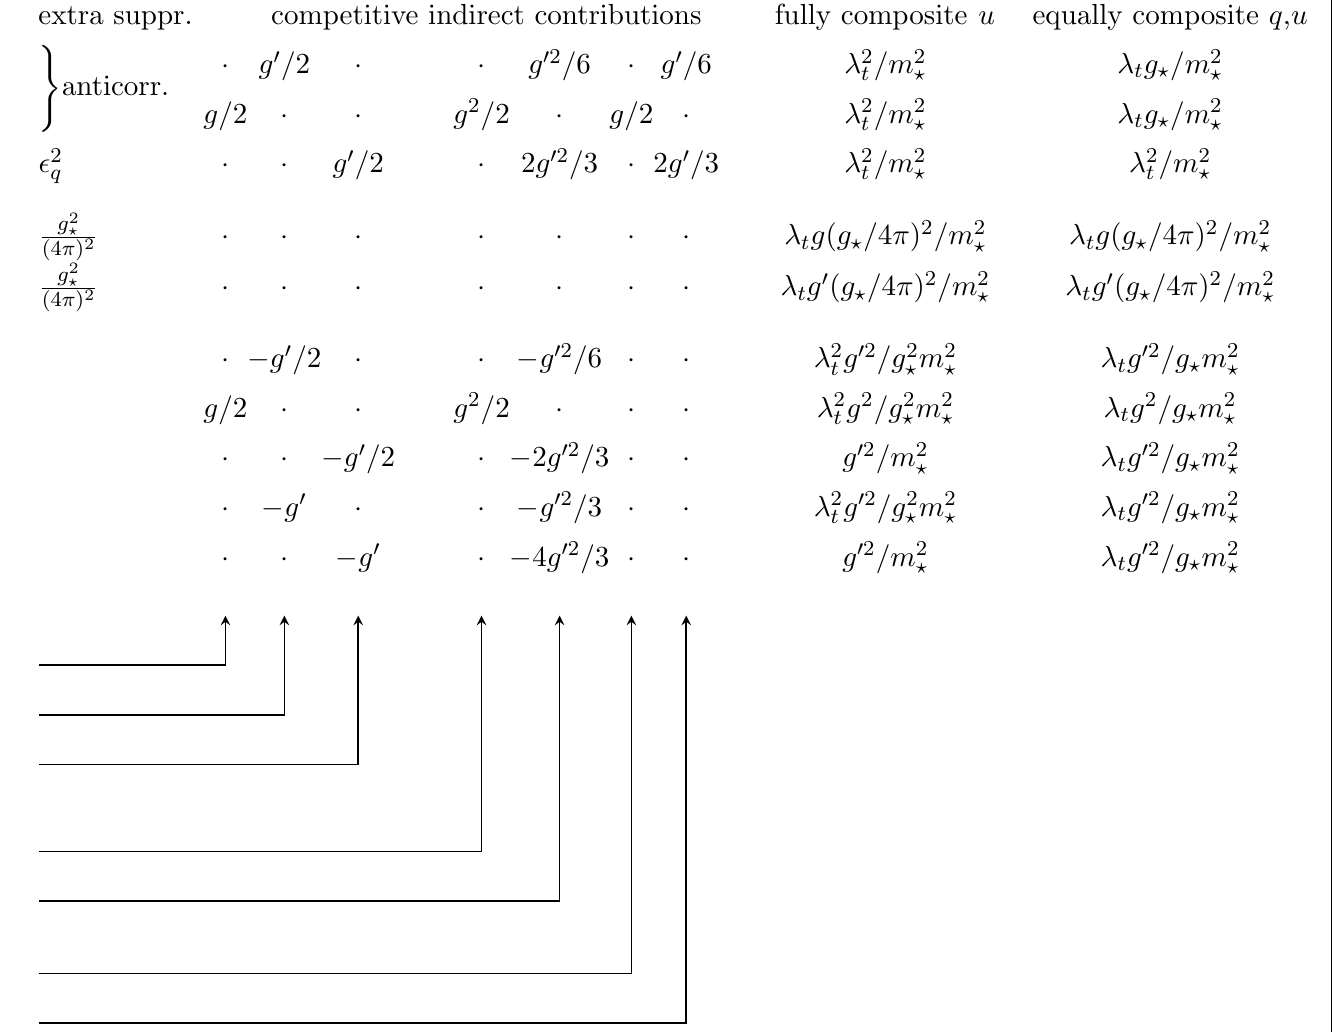
Table 1 . First column: direct application of the power-counting rules to estimate the coe(cid:14)cients of Warsaw-basis operators contributing to third-generation quark production and enhanced by top-quark mixings. Redundant operators from which they receive contributions, after application of the eom s for the electroweak gauge (cid:12)elds, are listed too. Second column: extra suppression arising from selection rules. Third column: additional factors a(cid:11)ecting the indirect contributions of redundant operators to Warsaw-basis operators after application of the eom s. Fourth and (cid:12)fth columns: dominant contributions in the case of a fully composite t ( (cid:15) t = 1, (cid:15) q = (cid:21) t =g ? ) p and of equally composite q and t ( (cid:15) q = (cid:15) t = (cid:21) t =g ? ). Subdominant contributions are suppressed by powers of g ( 0 ) =g ? , g ( 0 ) =(cid:21) t , or (cid:15) l;e g ? =g ( 0 ) . Numerical prefactors have been omitted in these last two